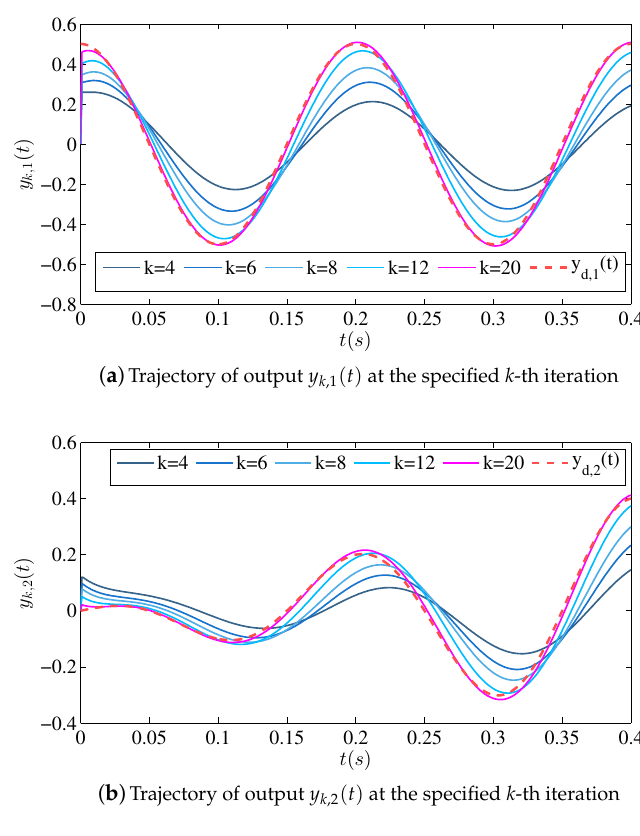
Figure 2. Trajectories of outputs y k , i ( t ) at the specified k -th iteration using open-loop iterative learning schemes